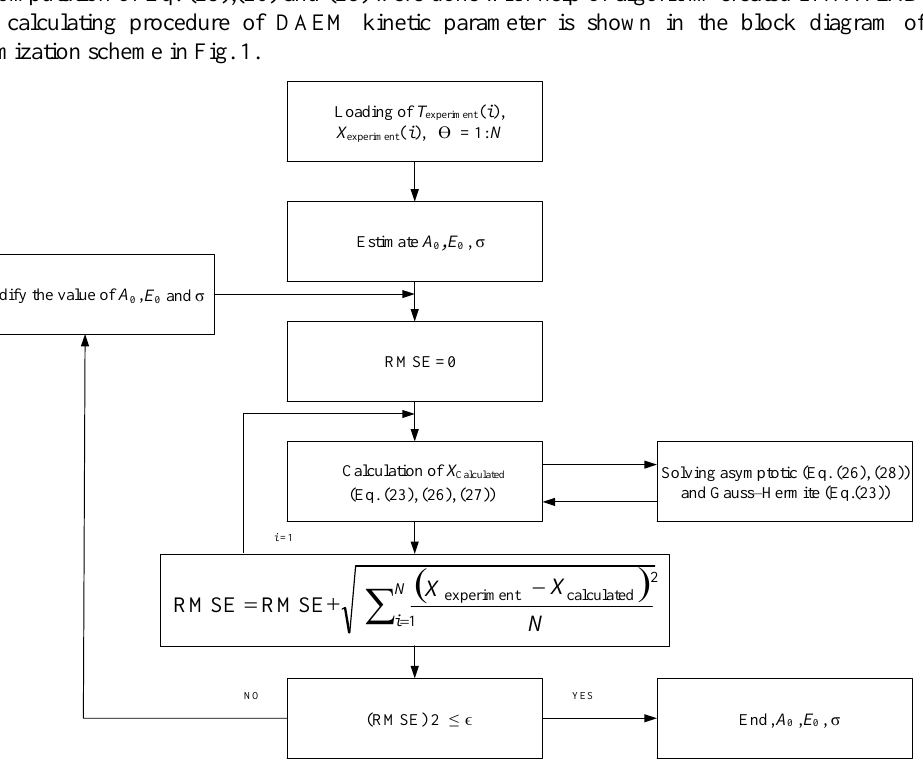
Fig.1. DAEM kinetic parameters optimization block